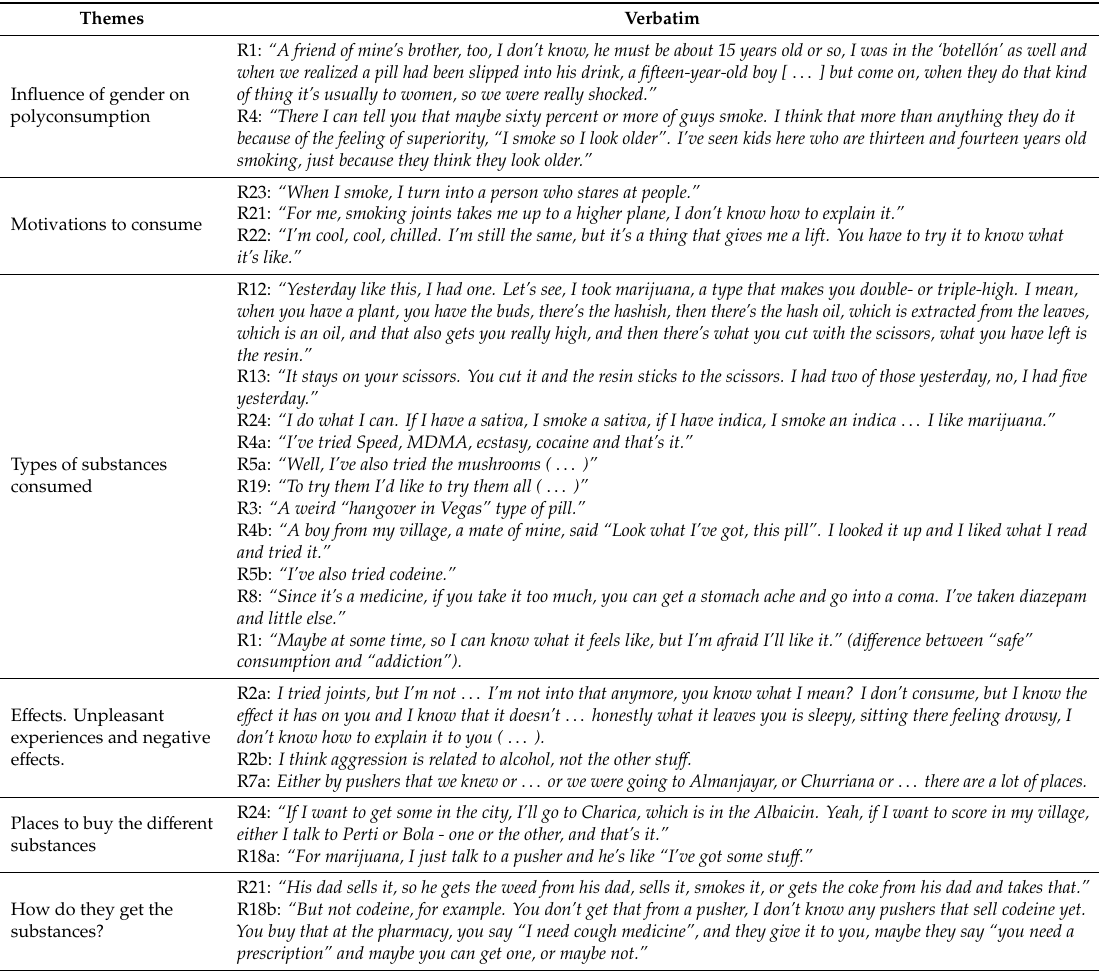
Table A1. Description of themes and distribution of verbatim